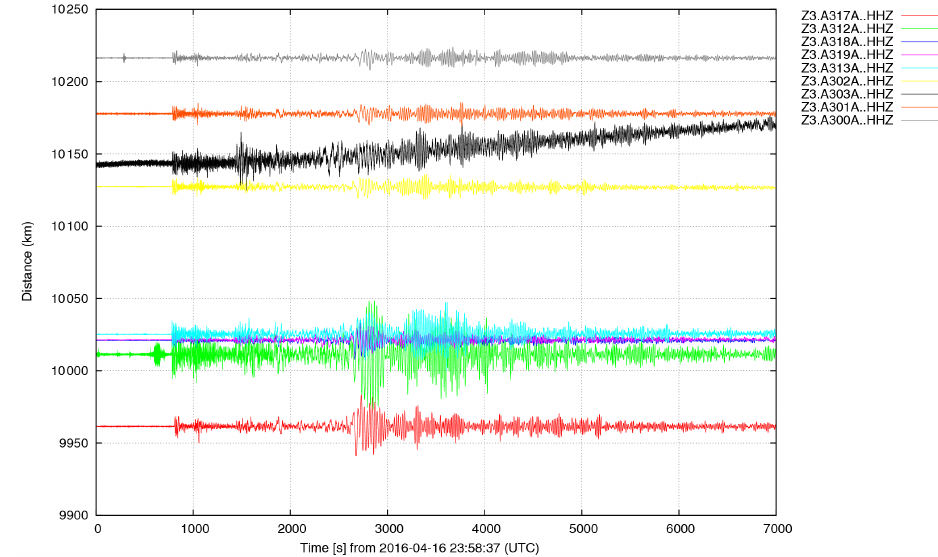
Figure 7. Example of waveforms recorded by the INGV AlpArray temporary stations for the M7.8 teleseismic earthquake occurred in Ecuador on 16 April 2016, 23:58:37 (UTC), focal depth 19.2km. Waveforms are corrected for instrument response. The black trace is from Z3.A303A (Lido station) on shore in the coastal strip of venetian lagoon and the drift is very likely related to the water